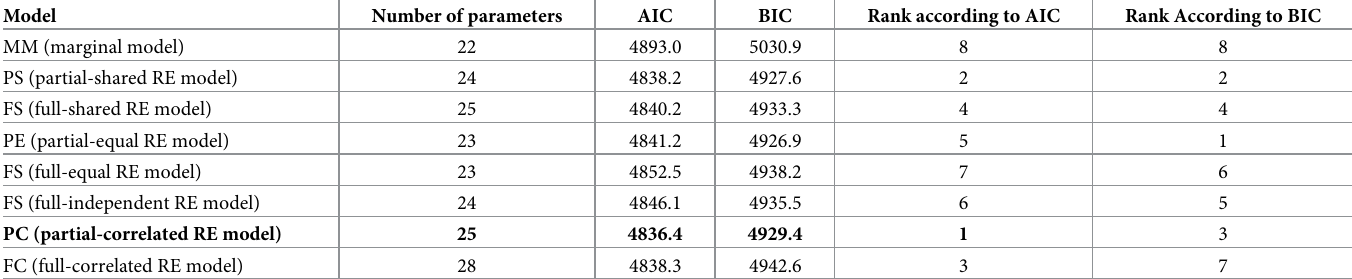
Table 2. Comparison of marginal model, and full-shared, partial-shared, full-equal partial-equal, full-independent, partial-correlated and full-correlated random- effects models.